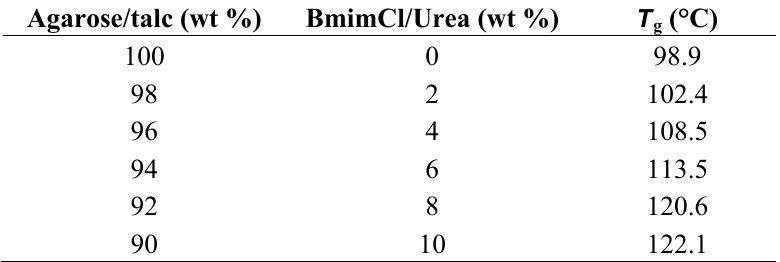
) of the agarose/talc composite g